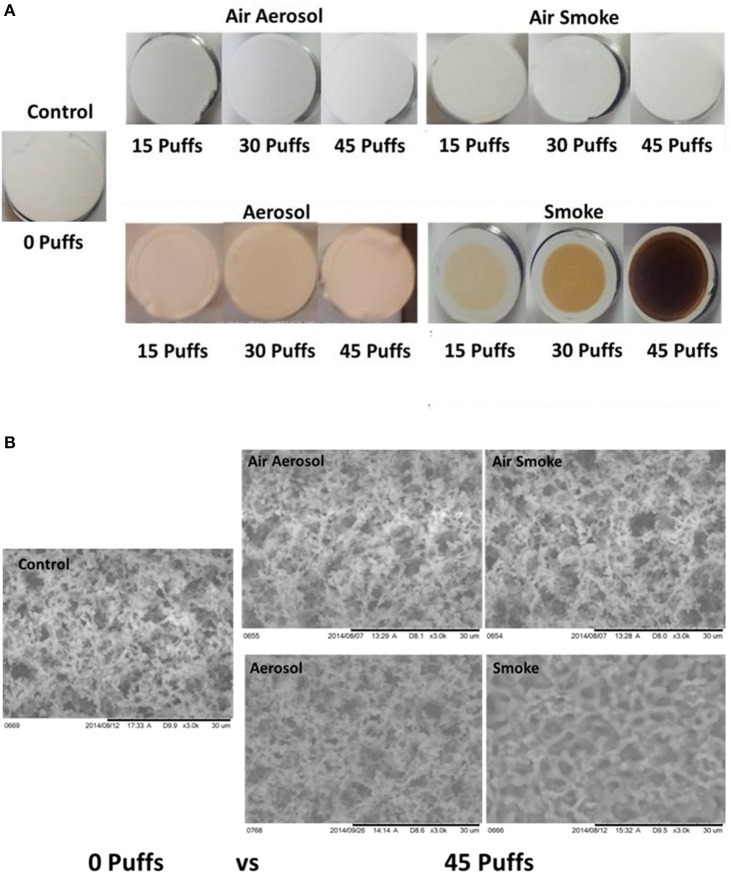
(A) Visual inspection Of MCE membranes after 0, 15, and 45 puffs of air, ECIG-generated aerosol and smoke and (B) SEM analysis of MCE membranes after exposure to 0 and 45 puffs of air, ECIG-generated aerosol and smoke. All SEM images shown at 3000X.